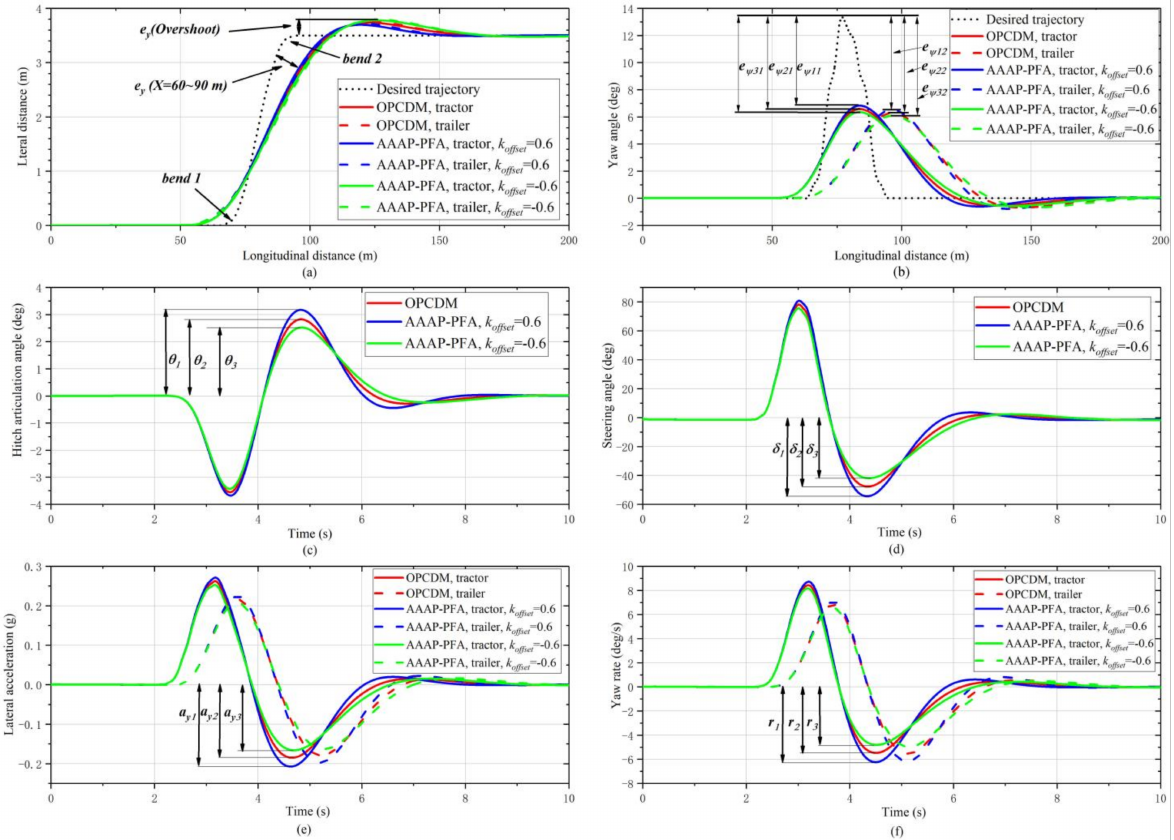
Figure 8. Simulation results of test 1 at a speed of 80 km/h. ( a ) Trajectory. ( b ) Yaw angle. ( c ) Hitch articulation angle. ( d ) Steering angle. ( e ) Lateral acceleration. ( f ) Yaw